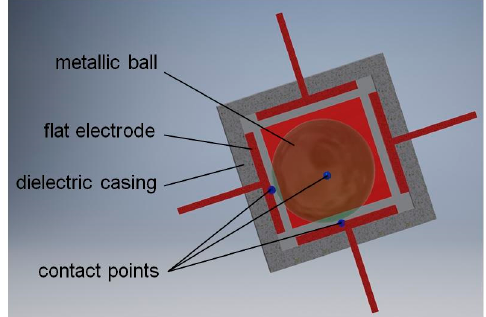
Figure 7. Principle of operation of a tilt sensor with eight detection sub-ranges.